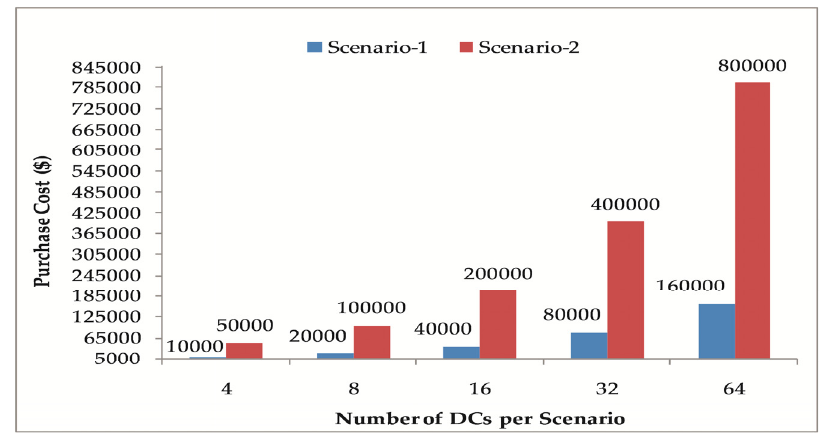
Figure 4. Purchase cost versus required number of DCs.